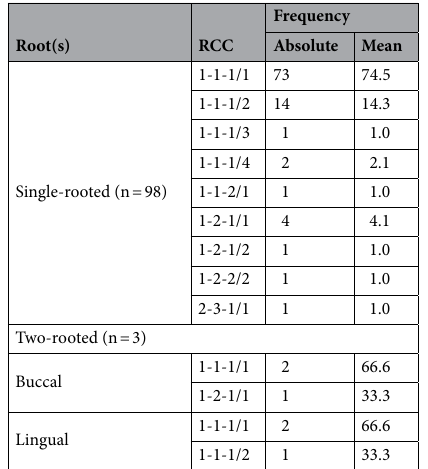
Frequency Absolute